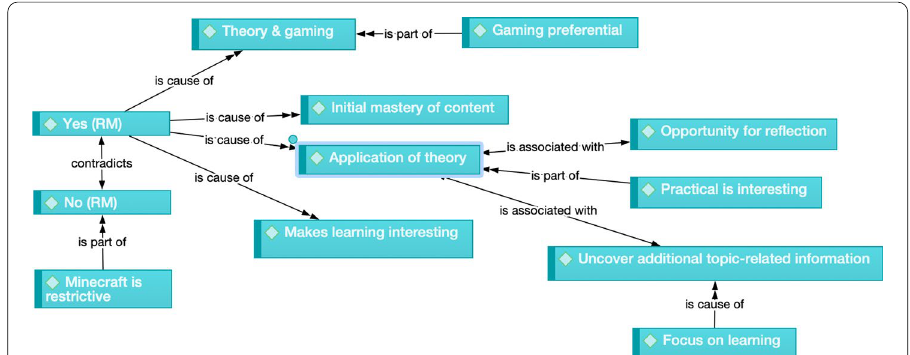
Fig. 6 Research methodology learning network